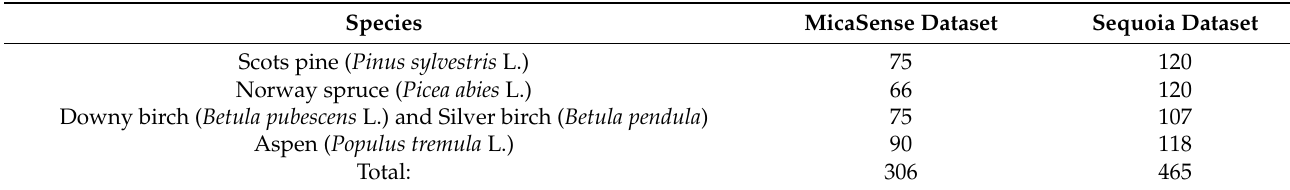
Table 1. Abundance of tree species in field data.